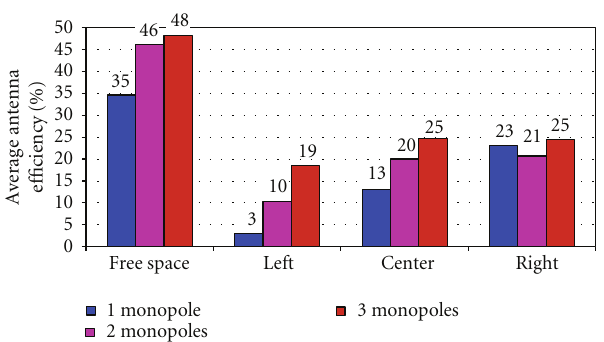
W PCB F 22: L-shaped monopole printed on a ground plane. e dimensions of the monopole antenna are mm with a strip width of 2mm, and it is located in the shorter edge of a PCB at a mm from the ground plane. e PCB dimensions distance 𝐿𝐿 = 23 mm and are PCB PCB gap = 4 𝐷𝐷 = 90 = 40 𝑊𝑊 𝐿𝐿